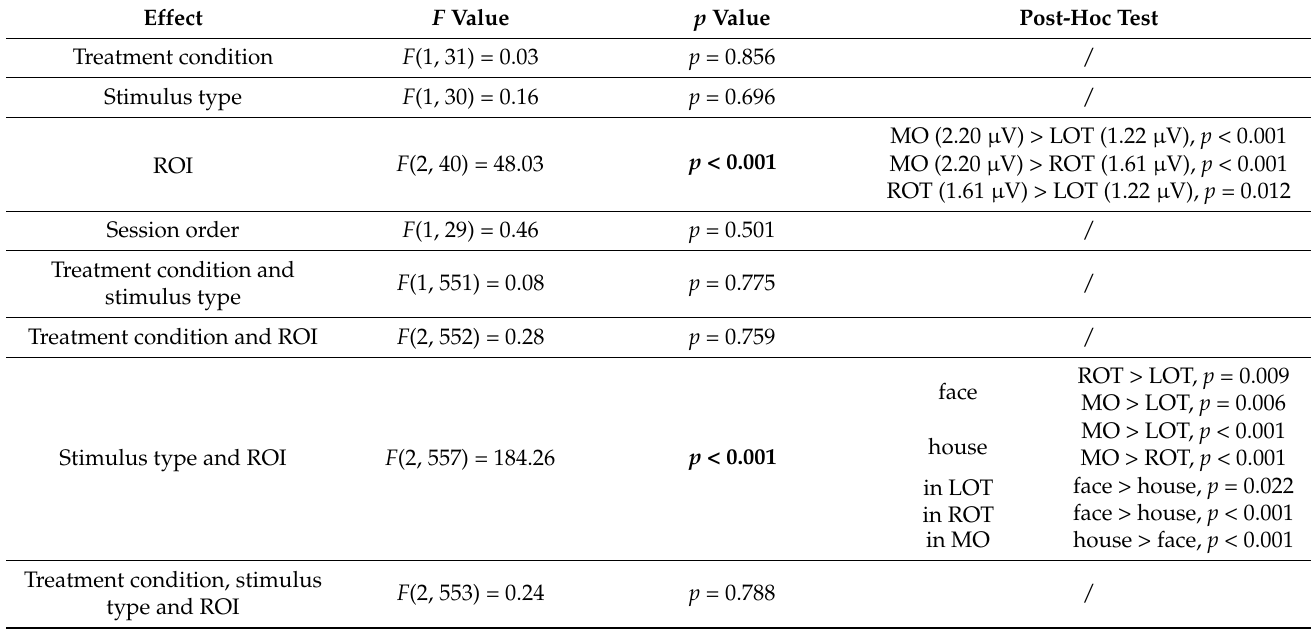
Table 1. Results of LMM analyses on neural responses with treatment condition (OT, PL), stimulus type (face, house) and ROI (LOT, ROT, MO) as fixed effects and session order (OT session first, PL session first) as nuisance covariate.